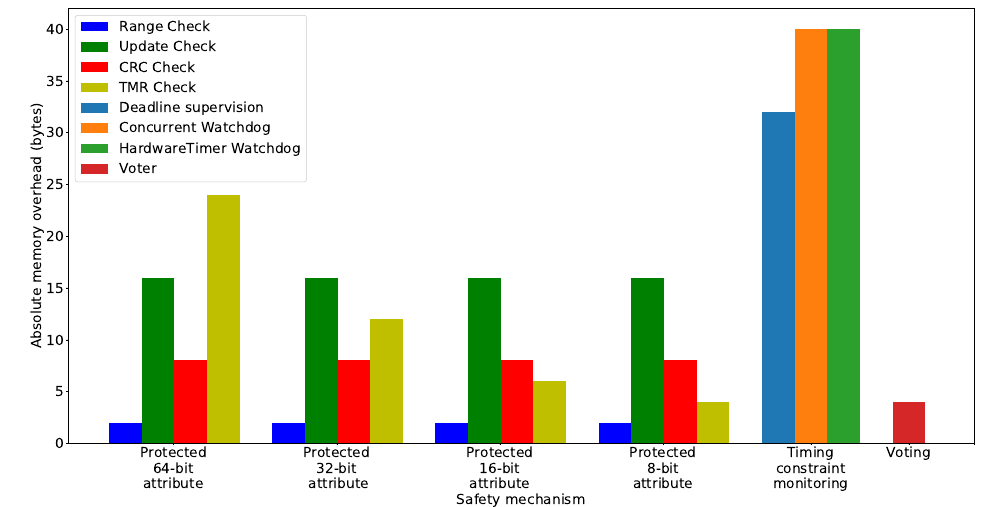
Figure 16. Absolute memory overhead of the generated safety mechanisms in bytes. For TCM , the absolute memory overhead per protected operation is between 32 and 40 bytes, depending on the specific mechanism. Deadline supervision has a smaller memory overhead than the watchdog variants, as the latter operate concurrently and require additional status variables for this